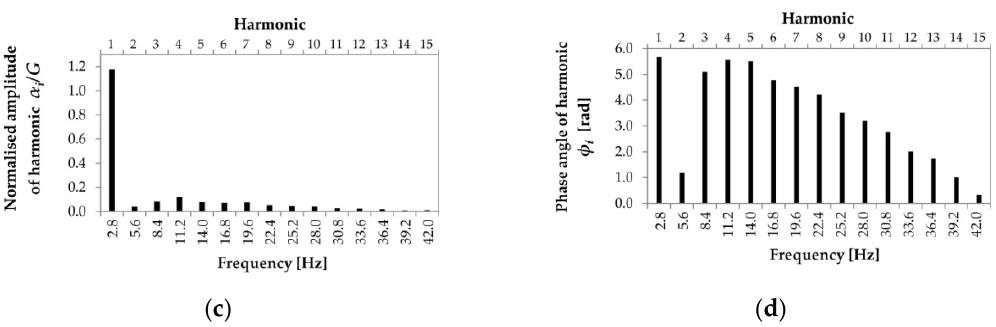
Figure 10. An example of an artificially generated vertical component of the ground reaction force for heel-strike running: ( a ) normalised ground reaction force F VGRF generated using the half-sine model and normalised impact peak generated using the impact peak function, ( b ) the sum of normalised VGRF and normalised impact peak (solid bold line) in relation to the results of laboratory tests (thin dashed lines), ( c ) the amplitudes spectrum of the generated F VGRF , ( d ) phase angles spectrum of the generated F VGRF .